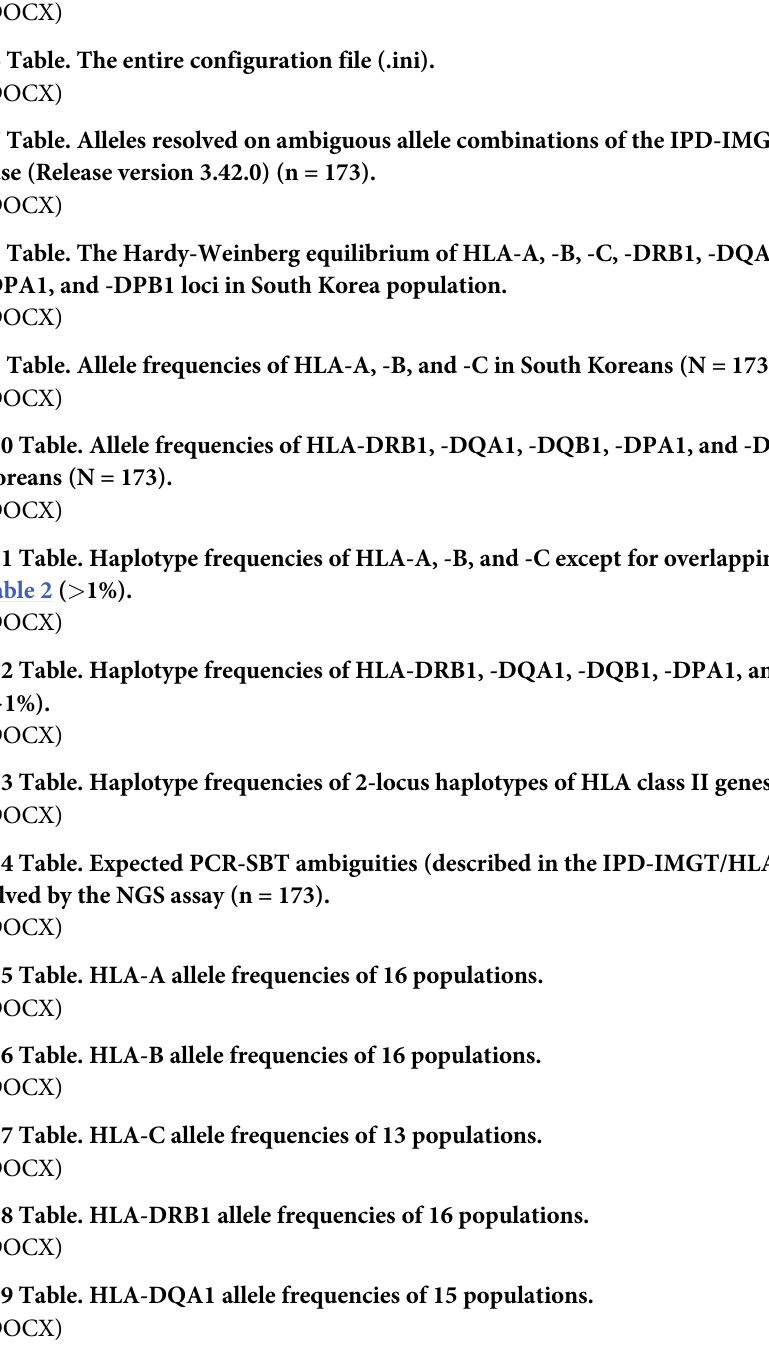
S7 Table. Alleles resolved on ambiguous allele combinations of the IPD-IMGT/HLA data-